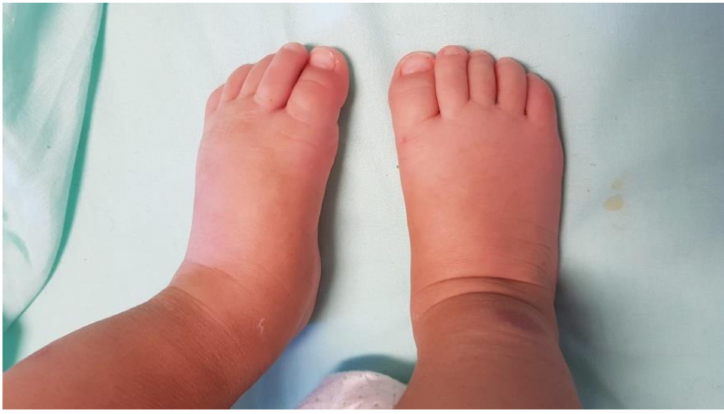
Figure 2. Oedema of the feet and